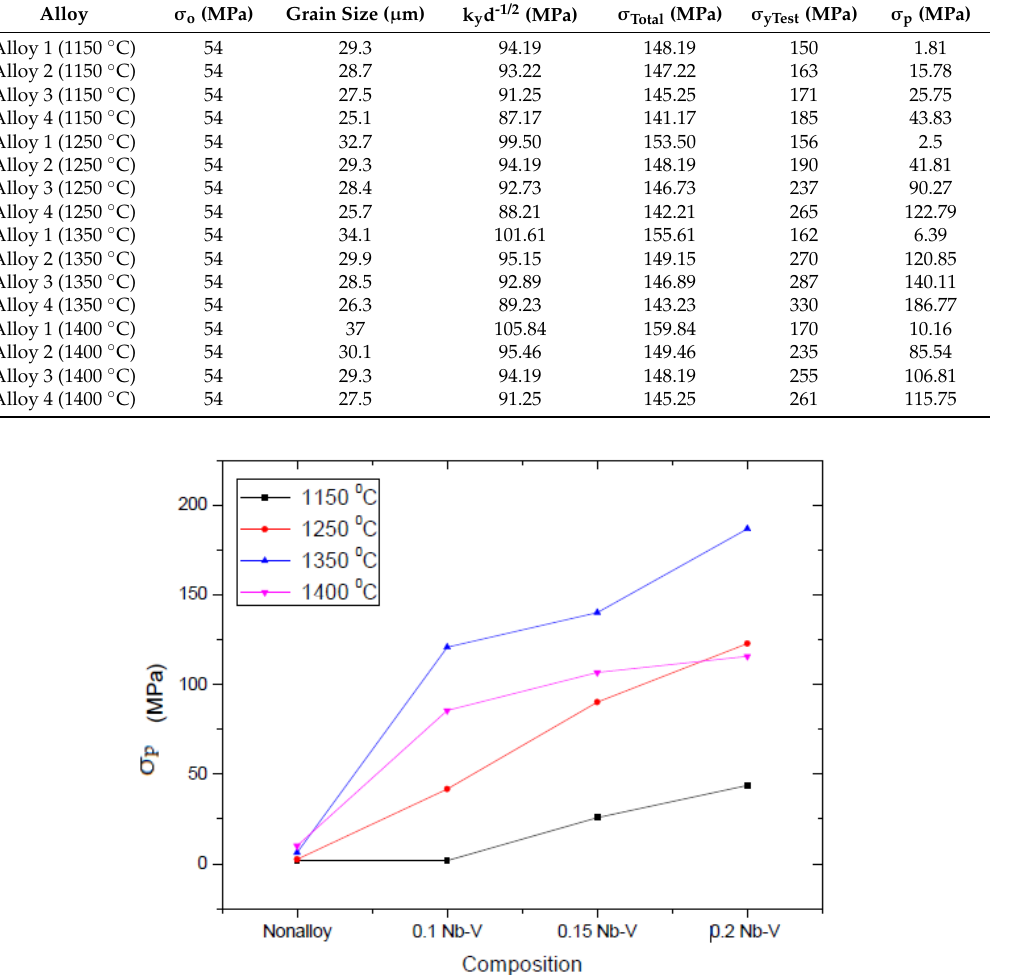
Table 4. Structure properties analyses of PM steel and microalloyed PM steels tensile tested at room temperature.